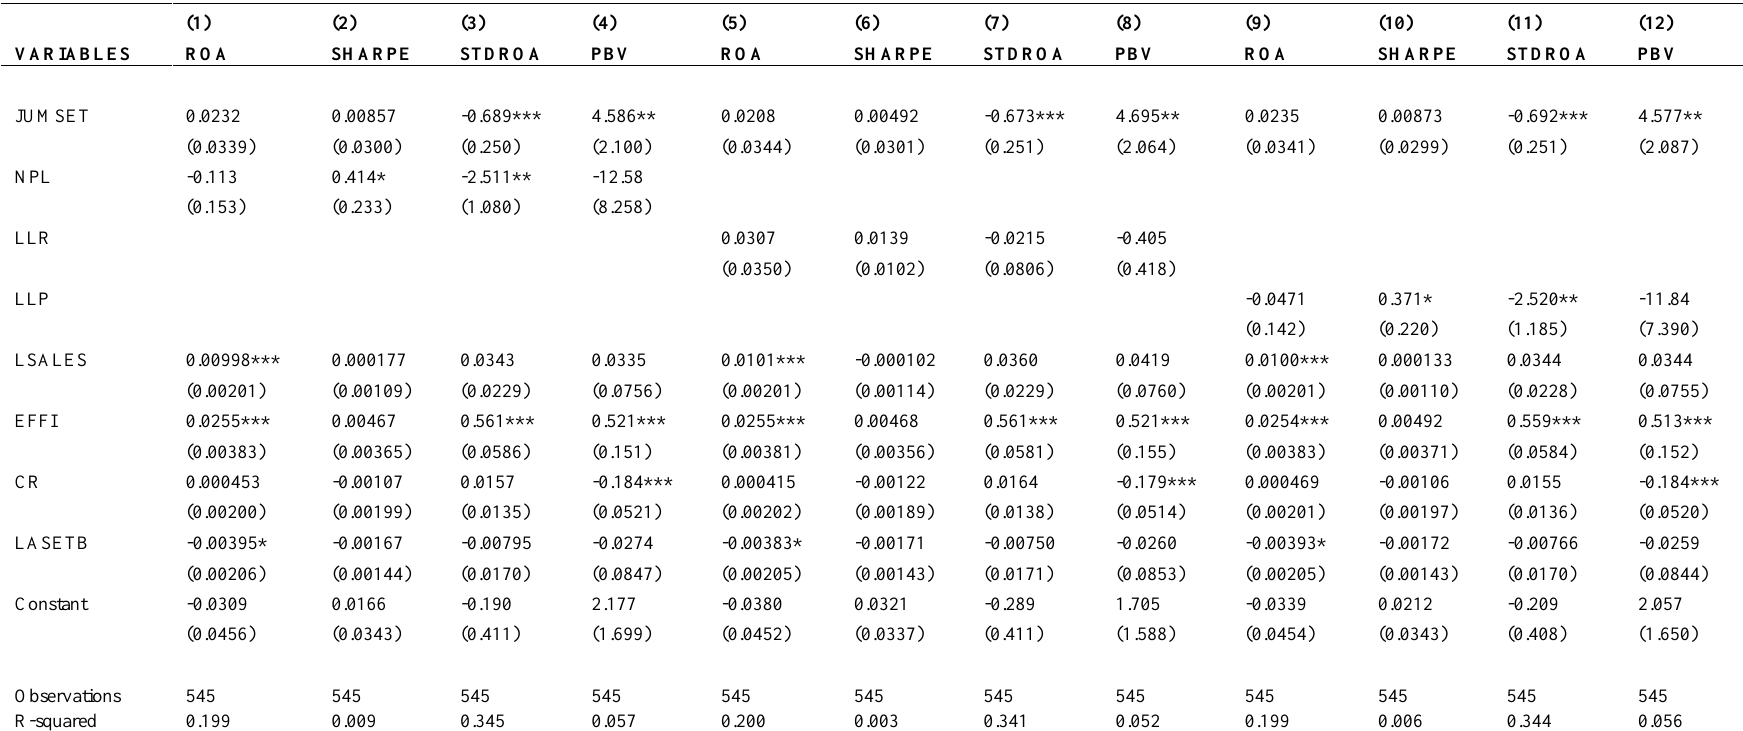
Table 3: Regression results with banks’ risk as independent